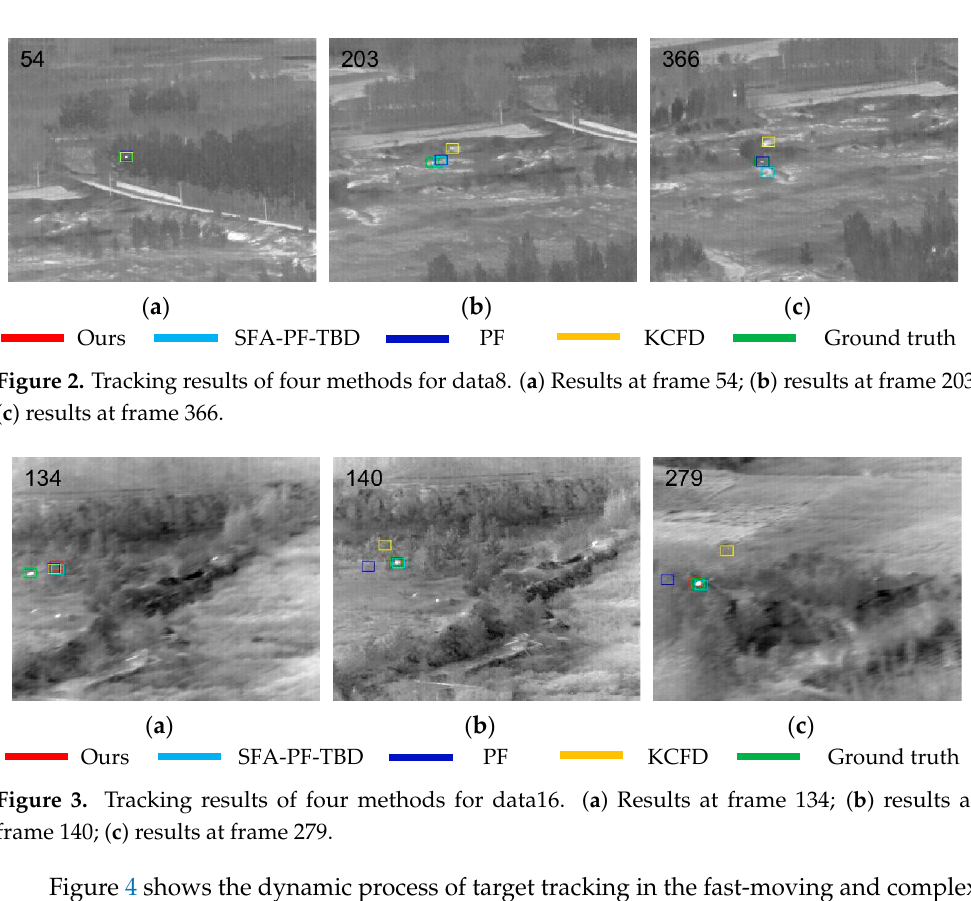
Ground truth Figure 1. Tracking results of four methods for data5. ( a ) Results at frame 127; ( b ) results at frame 700; ( c ) results at frame 768. Figure 2 shows the dynamic process of target tracking in the complex background sequence (data8). The images in this sequence have a complex background accompanied by objects with a grayscale similar to the target. As shown in Figure 2a, the target is obvi-